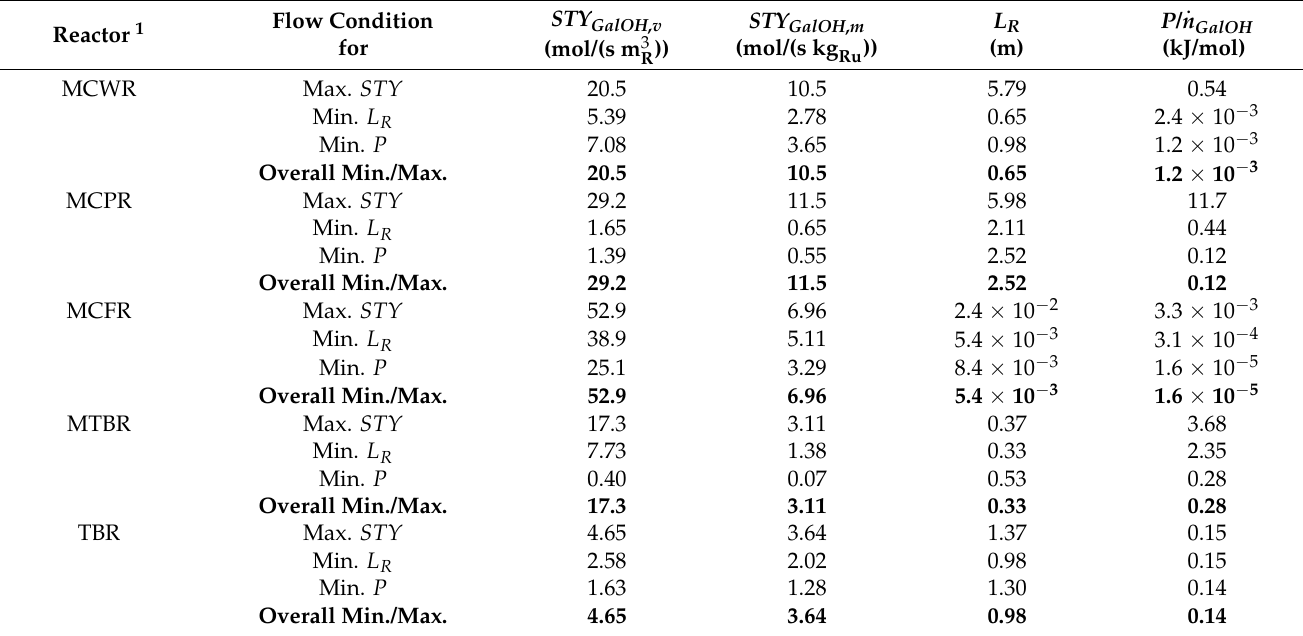
Table 2. Comparison of the 5 investigated reactor configurations based on quantitative criteria derived from the process simulations. Reactor 1